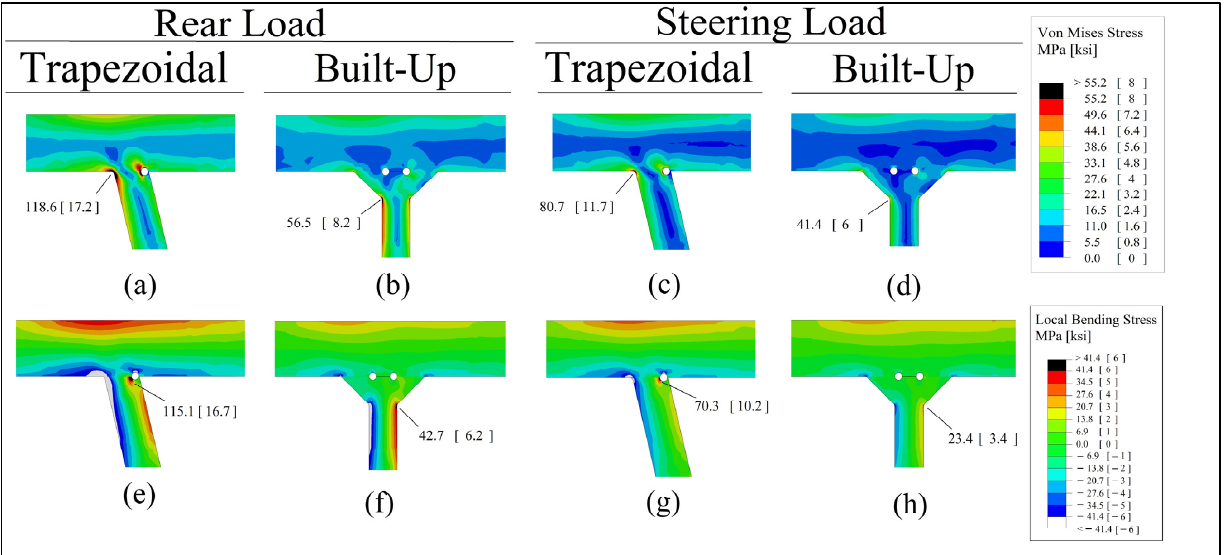
Figure 18. Von Mises stress distribution under the steering wheel load in continuum case 1.